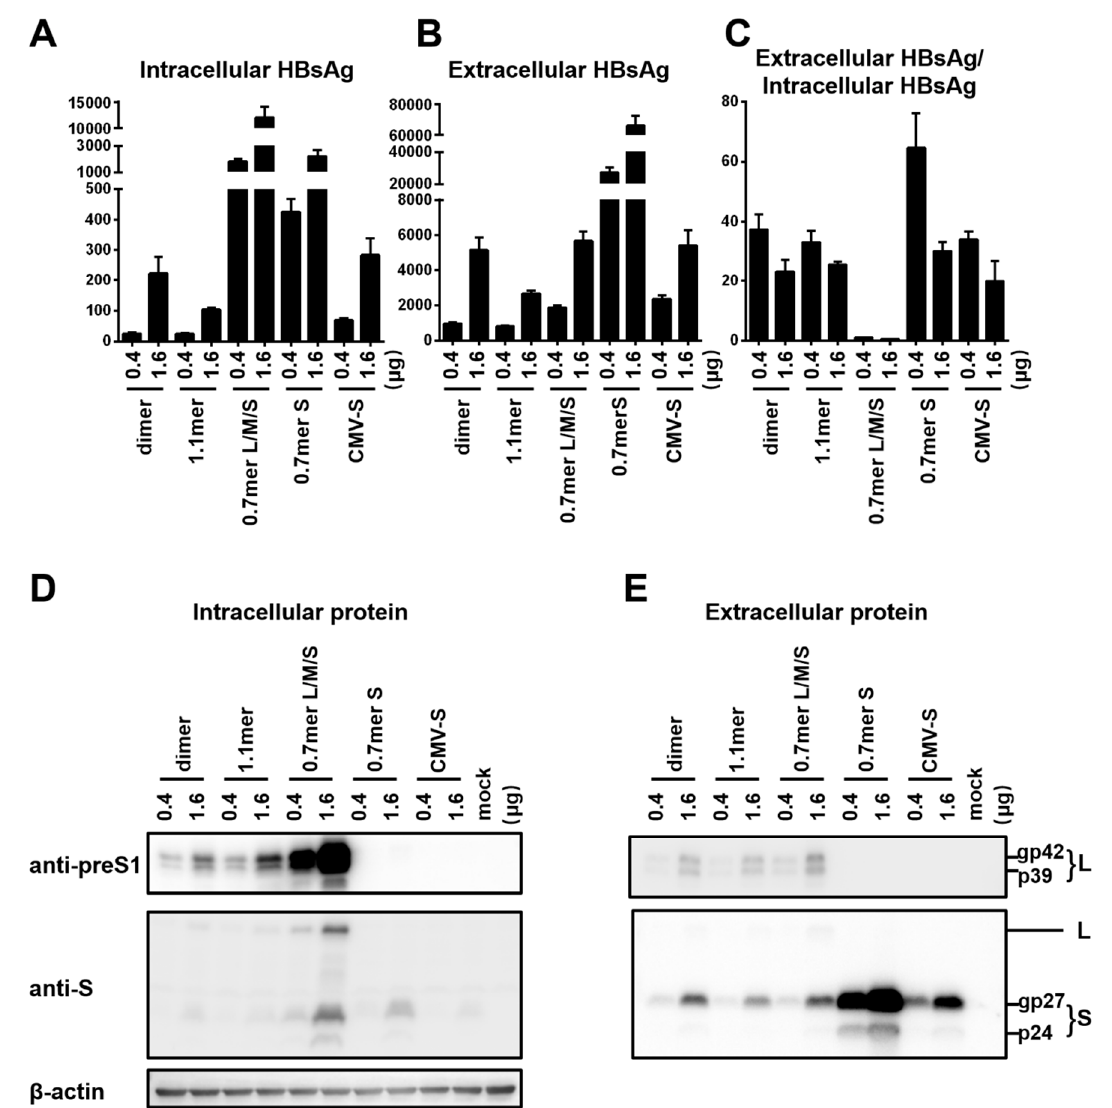
Figure 4. Comparison of five types of replication or expression constructs for efficiency of envelope protein expression and HBsAg secretion: the genotype D clone. Huh7 cells in 6-well plates were transfected with 0.4 or 1.6 μ g of various HBV DNA constructs of geno1.2 (genotype D). Cells and culture supernatant were harvested four days later. ( A , B ) Calculated total amount of HBsAg (OD 450 ) from cell lysate ( A ) and culture supernatant ( B ), with data averaged from three independent transfection experiments. ( C ) Calculated ratio of extracellular/intracellular HBsAg. ( D , E ) Western blot analysis of intracellular ( D ) and extracellular ( E ) L and S proteins from same volume of cell lysate or culture supernatant by anti-preS1 and anti-HBs antibodies, respectively. β -actin served as an intracellular loading control.